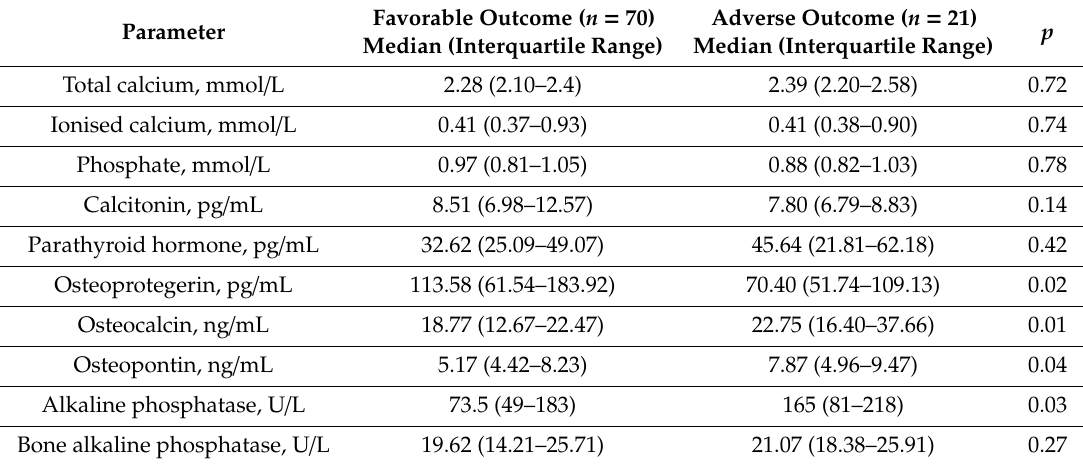
Table 4. Parameters of mineral homeostasis in relation to the adverse cardiovascular outcome upon CABG